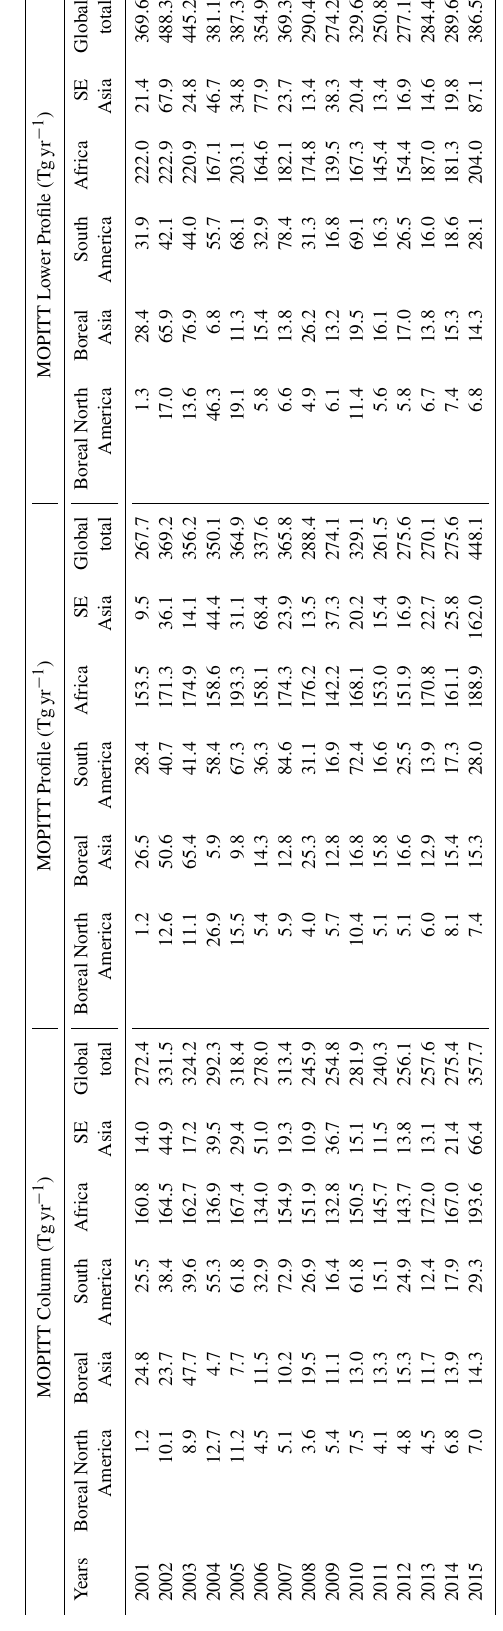
tool for evaluating the variation of tropospheric OH